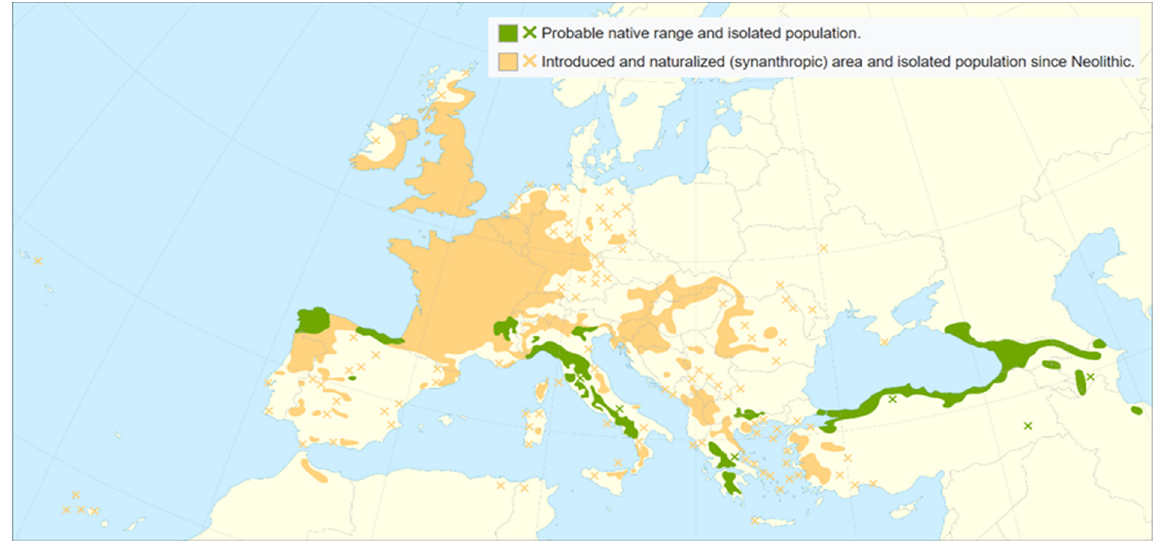
Figure 2. Distribution map of Castanea sativa [8].